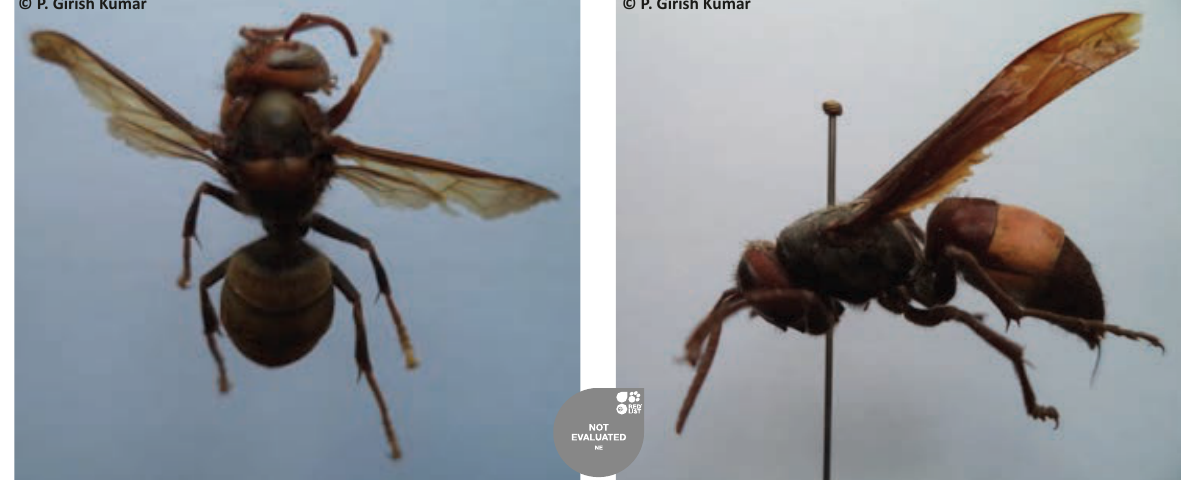
They are usually solitary and rarely subsocial. They make burrows in the soil or wood, or exposed mud nests. The younger ones are provisioned with the larvae of Coleoptera, Lepidoptera or Symphyta. Eleven genera and 19 species are recorded from Chhattisgarh.